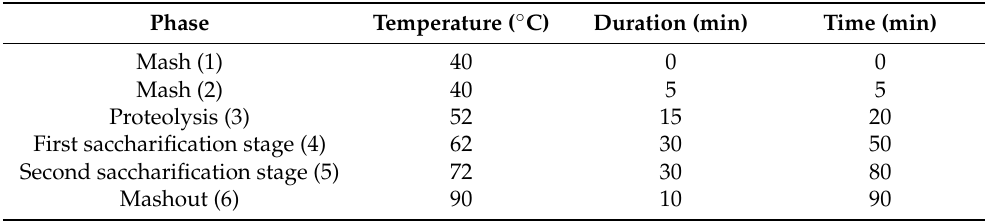
Table 1. Individual sampling phases, phase duration, and total mashing time of individual samples (own